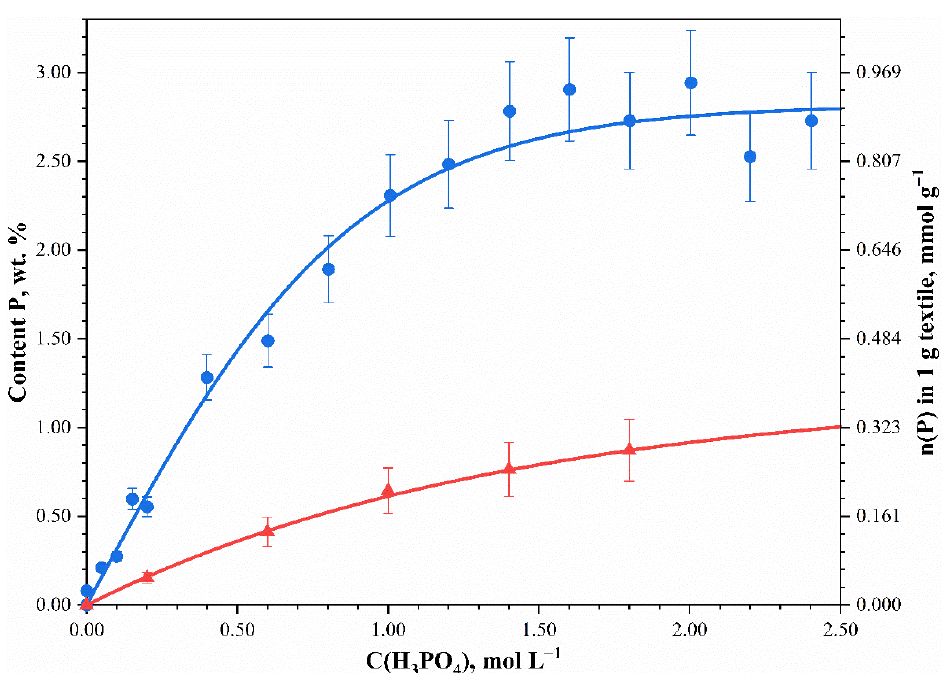
Figure 2. The phosphorus content (wt.% and mol in 1 g textile) in the phosphorylated mercerized (circles) and unmercerized (triangles) fabrics versus phosphoric acid concentration in the phosphorylating solution.